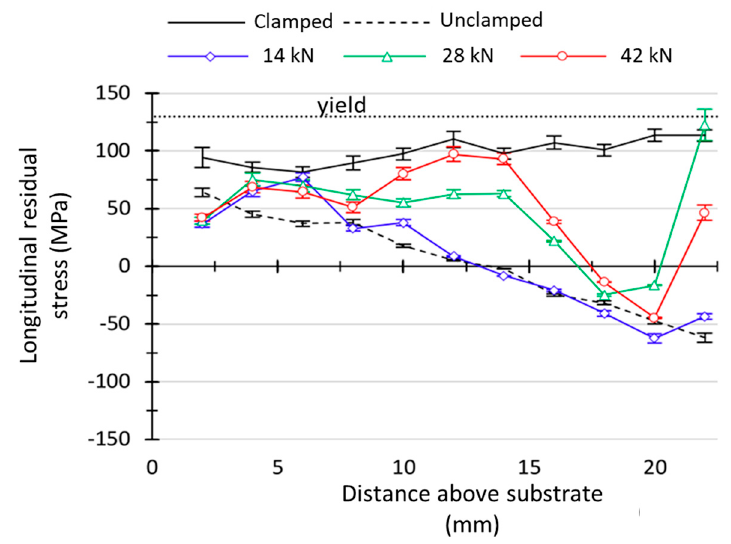
Figure 24. Longitudinal residual stresses of aluminum parts after rolling (adapted from [19]).